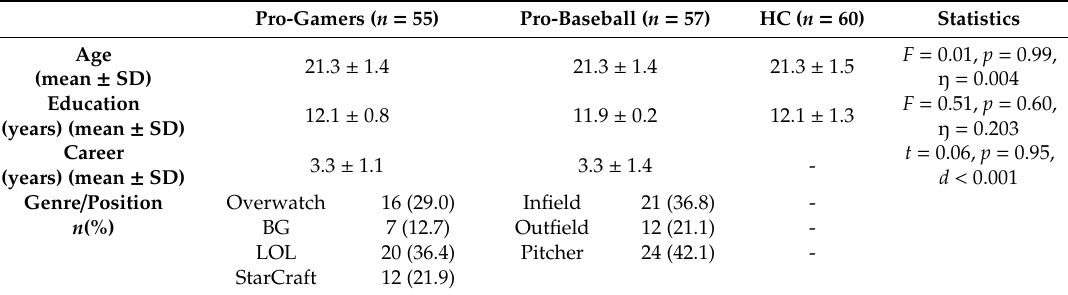
Table 1. Demographic